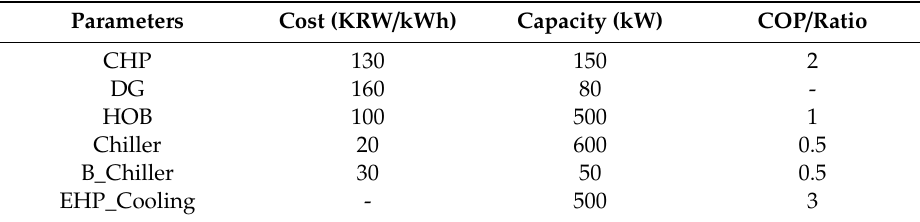
Table 1. Input parameters for energy supply facilities.